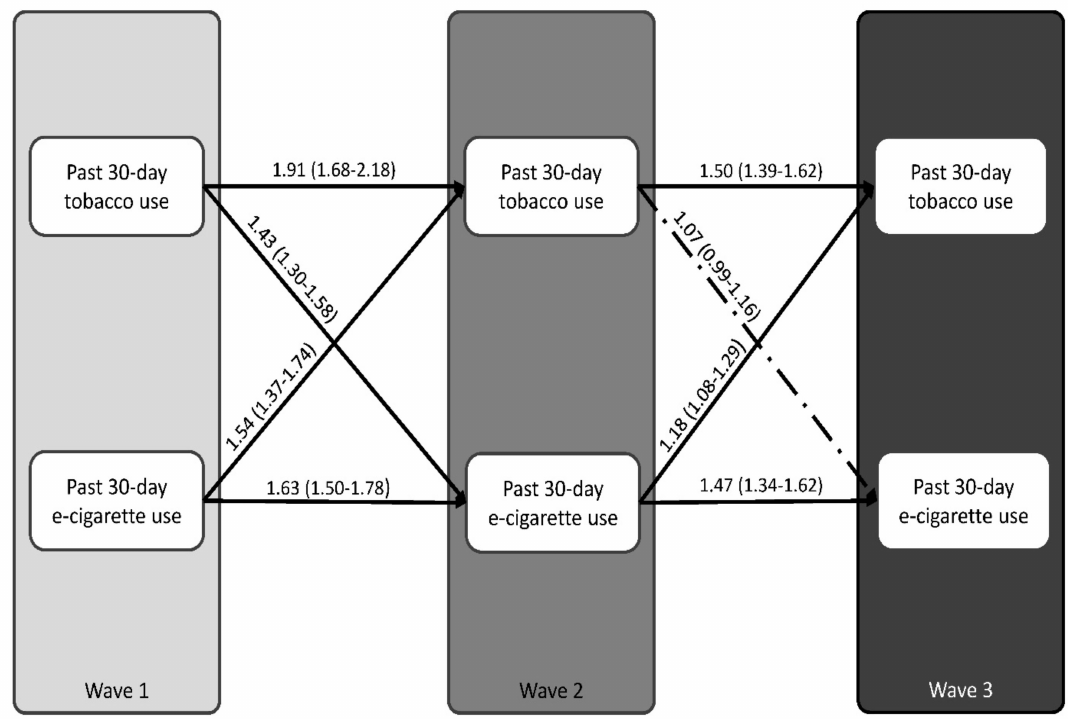
Figure 1. Relationships between current tobacco use and e-cigarette use among youth participating in all three waves of the study (n = 6729), adjusted for gender, grade, ethnicity, having friends who smoke, weekly spending money, cannabis use, and binge-drinking behaviors. Path estimates were exponentiated to obtain odds ratios (ORs). Adjusted ORs and 95% confidence intervals are presented for all pathways. The solid lines indicate significant e ff ects ( p < 0.05), while the dashed lines indicate non-significant e ff ects ( p > 0.05). Model fit indices: residual mean squared error (RMSE) = 0.032, comparative factor index (CFI) = 0.81, Tucker–Lewis Index (TLI) =